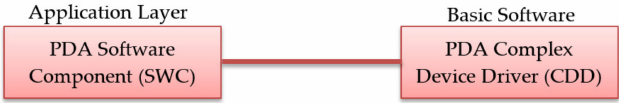
Figure 5. Private Data Adapter module design.